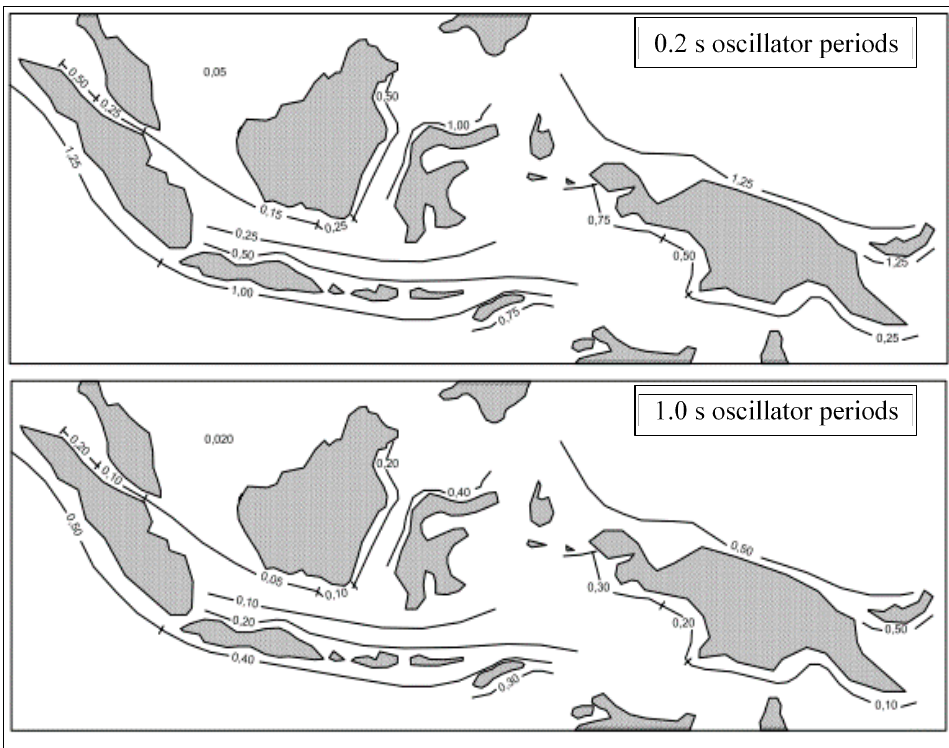
Figure 2. Damping [26].